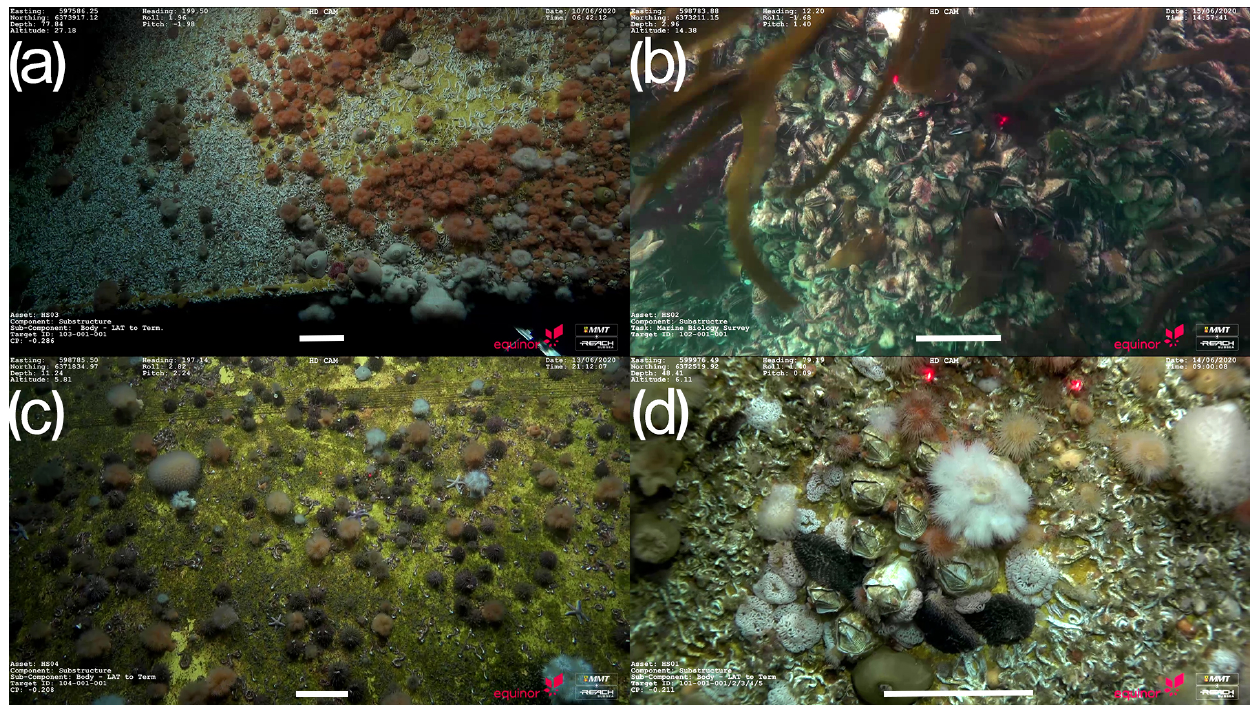
Figure 5. Example of epifouling colonisation on turbine substructures. (a) Spirobranchus sp. and M. senile at the bottom of the HS03 substructure. (b) Substructure HS02, with Mytilus spp., Laminaria sp. and potential amphipod tubes at 3m depth. (c) Substructure HS04, with grazing sea urchins and biofilm at 11m depth. (d) Substructure HS01, with nudibranchs ( A. papillosa ) and barnacles (Balanoidea) at 48m depth. Scale bar: